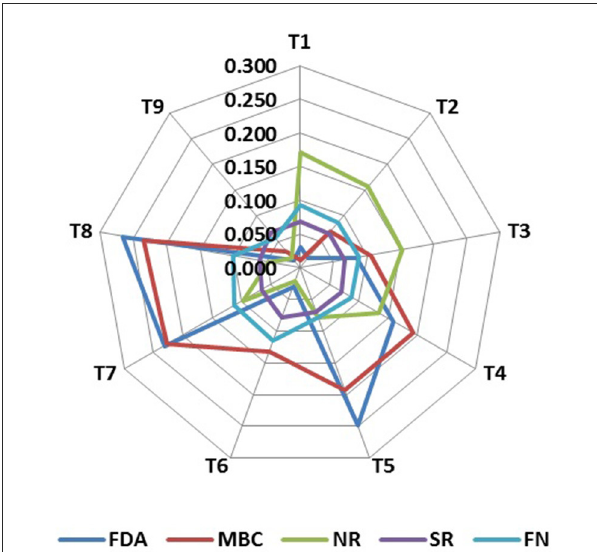
FIGURE4 Radar graph depicting the average linear scores of key indicators as influenced by soil-nutrient management treatments. T1: reduced till direct seeded rice–zero till barley (RTDSR–ZTB); T2: reduced till direct seeded rice–zero till barley–green gram (RTDSR–ZTB–Gg); T3: zero till direct seeded rice–zero till barley–zero till green gram (ZTDSR–ZTB–ZTGg); T4: reduced till direct seeded rice–zero till barley + rice residue at 4 t/ha (RTDSR–ZTB RR4 ); T5: reduced till direct seeded rice–zero till barley + rice residue at 6 t/ha